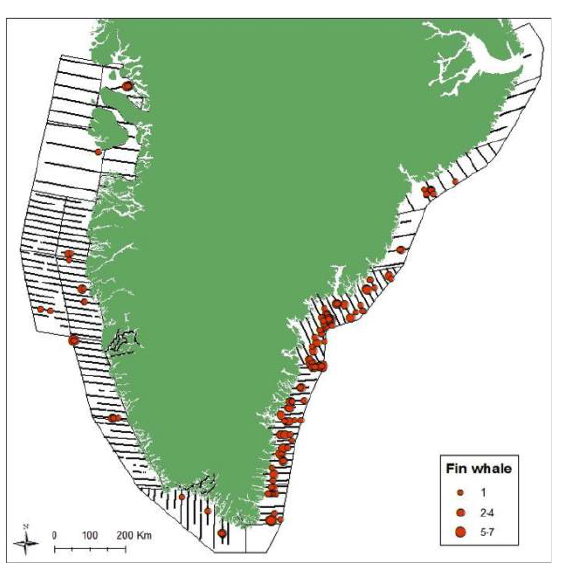
Figure 5. Survey effort in sea states <5 and sightings with group sizes of fin whales in East and West Greenland. The number of sightings of fin whales in sea states <5 was about 4 times higher in East Greenland compared to West Greenland.